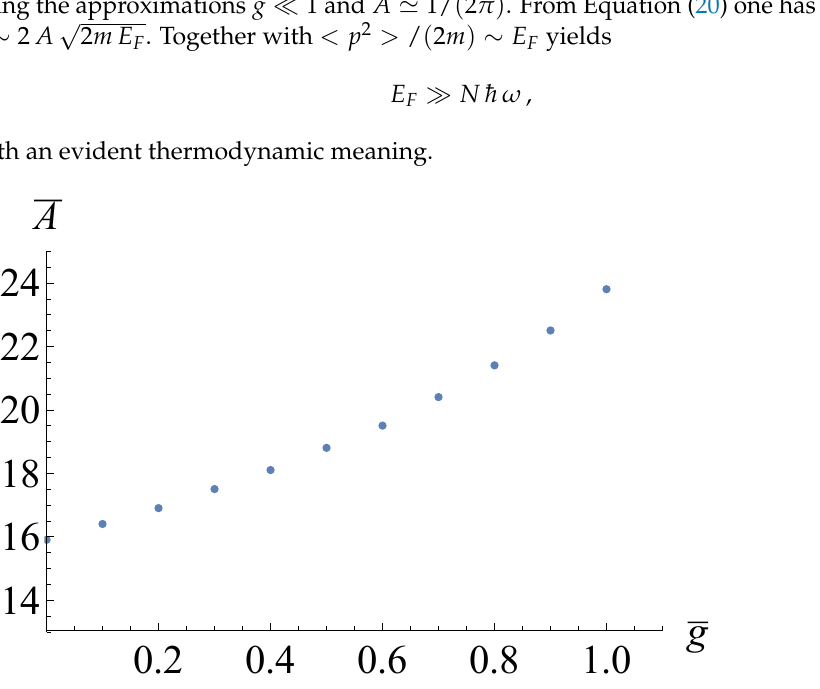
Figure 2. Numerical solution of Equation (24) for 0 ≤ ¯ g ≤ 1, where the interaction strength ¯ g and the normalization constant ¯ A are given in Equation (22).